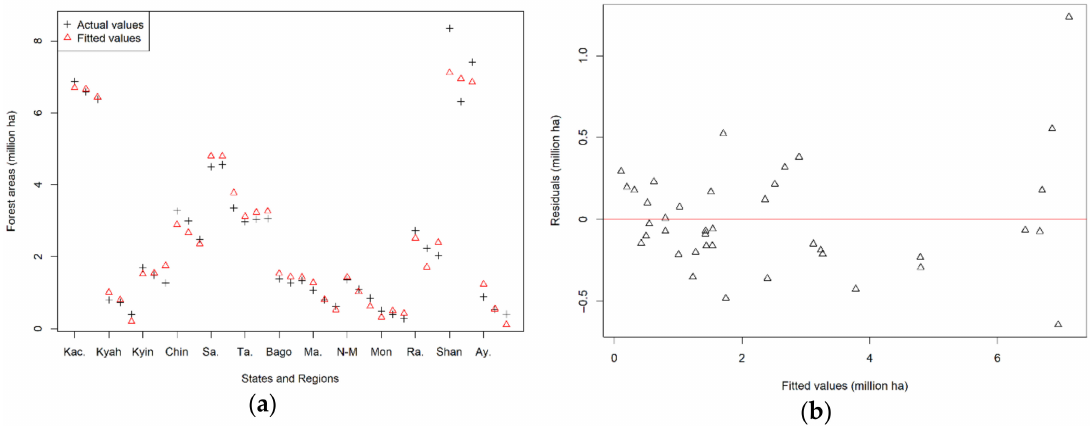
Figure 3. Visual model validation: ( a ) Fitted values versus actual values; ( b ) residuals versus fitted values. Kac.: Kachin; Kyah: Kayah; Kyin: Kayin; Sa.: Sagaing; Ta.: Tanintharyi; Ma.: Magway; N-M: